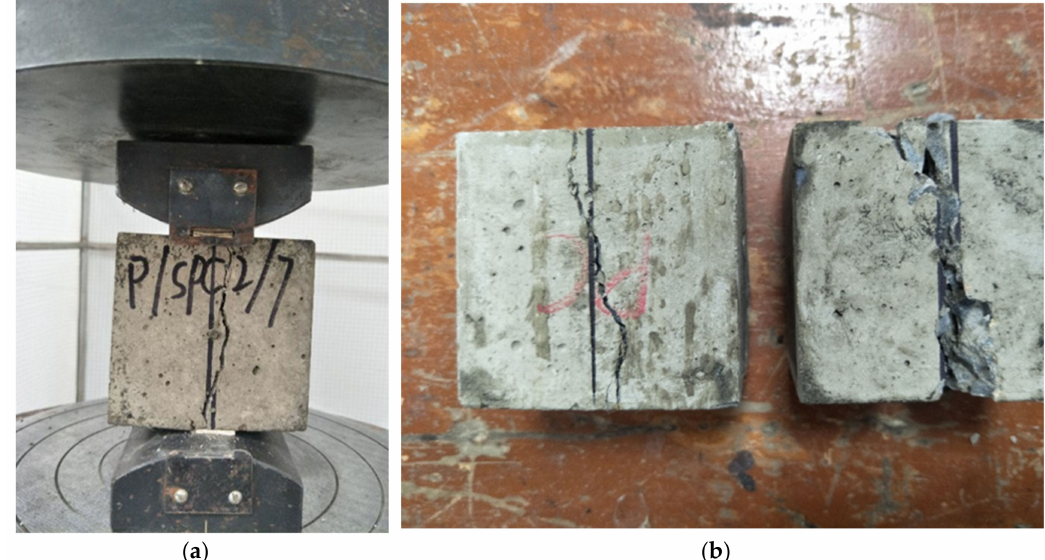
Figure 5. Splitting tensile test and the damaged specimens after the test. ( a ) Splitting tensile test; ( b ) damaged specimens after the splitting tensile test.